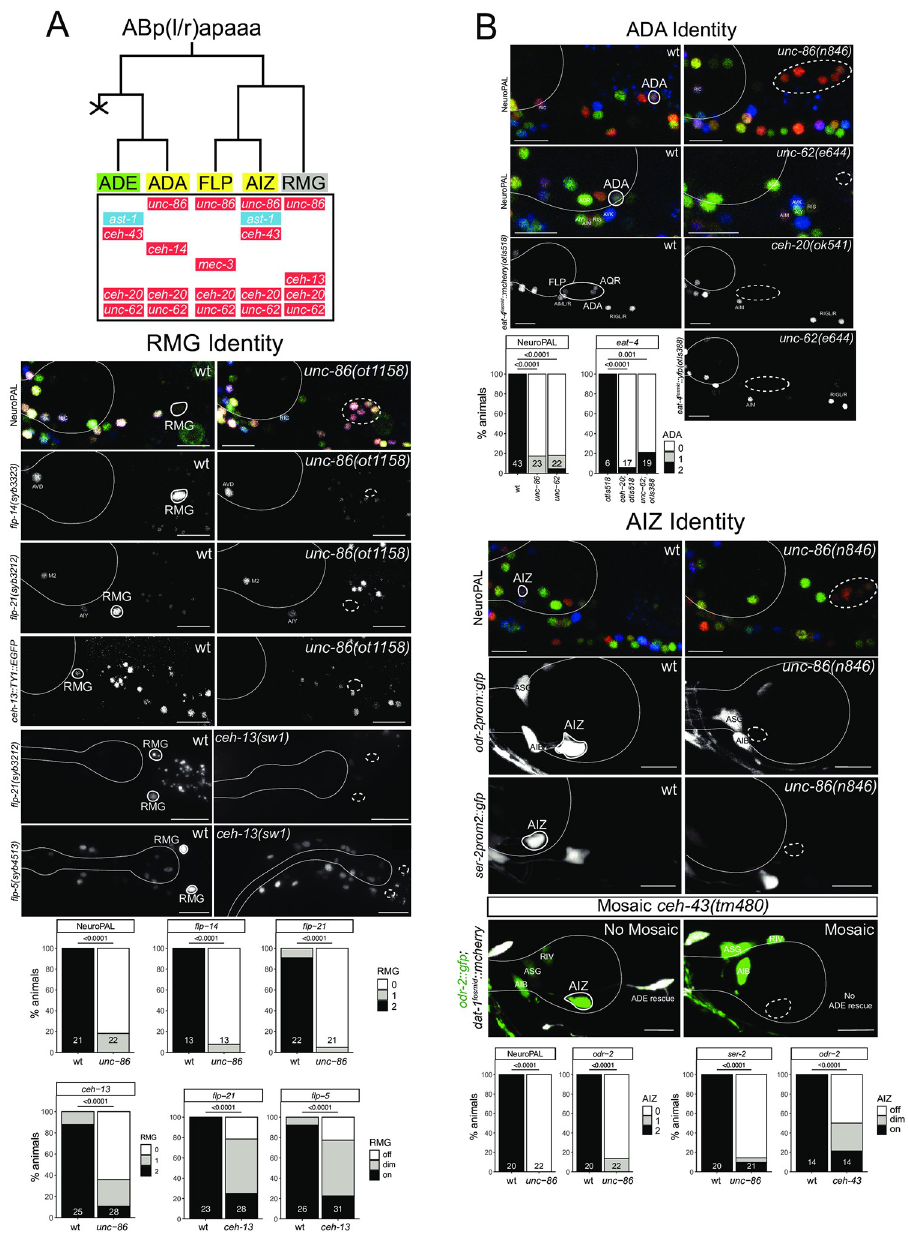
Fig 11. POU, MEIS and HOX genes control neuron identity in the anterior deirid lineage. Fig 11A: Lineage diagram depicting the generation of the anterior deirid neurons. Shown below each neuron in the lineage are the transcription factors known to be expressed in each of the respective neurons. Expression patterns for homeodomain proteins (all except AST-1) in the lineage are from [6, 91] and AST-1 is from this paper (S6 Fig). Green shading: dopaminergic neuron; yellow shading: glutamatergic neuron, grey shading: peptidergic neuron, red shading: homeobox gene, blue shading: non-homeobox gene. Fig 11B: Marker analysis in the anterior deirid lineage of wild- type and mutant animals. ADA Identity: unc-62(e644) and unc-86(n846) mutant animals show a loss of NeuroPAL ( otIs669 ) in ADA. Additionally, unc-86(n846) mutant animals show a loss of an eat-4 fosmid reporter ( otIs518 ) in ADA. Representative images of wild type and mutant worms are shown with 10 μ m scale bars. Graphs compare expression in wild type and mutant worms with the number of animals examined listed at the bottom of the bar. P- values were calculated by Fisher’s exact test. With two different eat-4 fosmid based reporters, unc-62 and ceh-20 mutants also show differentiation defects in other neurons in the location of the anterior deirid, besides ADA (namely, FLP and AQR neurons). RMG Identity: unc-86(ot1158) mutant animals show a loss of RMG marker expression, including NeuroPAL ( otIs669 ), a flp-14 CRISPR reporter ( syb3323 ), a flp-21 CRISPR reporter ( syb3212 ), and a